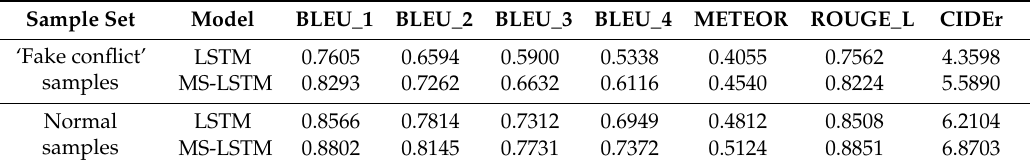
Table 8. Metrics of the LSTM and MS-LSTM in the validation set when using only the ‘fake conflict’ samples or normal samples.